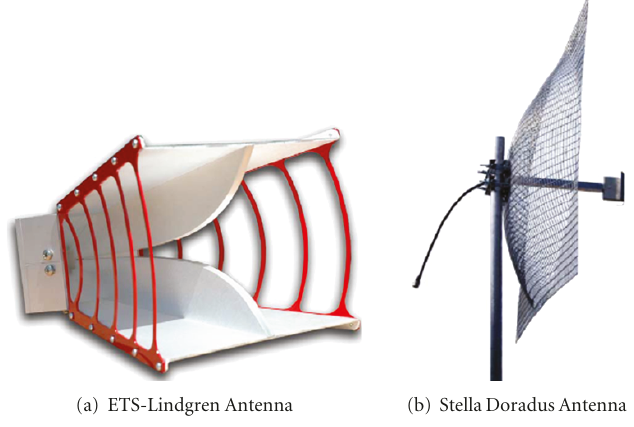
Figure 3: Directive antennas used at the emitter.